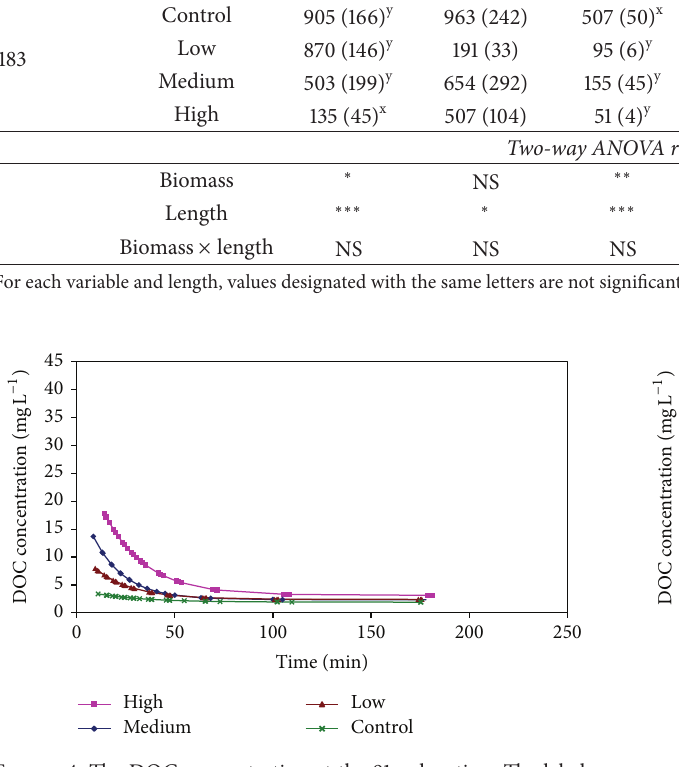
Figure 5: The DOC concentration at the 183m location. The labels High, Medium, Low, and Control indicate the amount of residue biomass in the